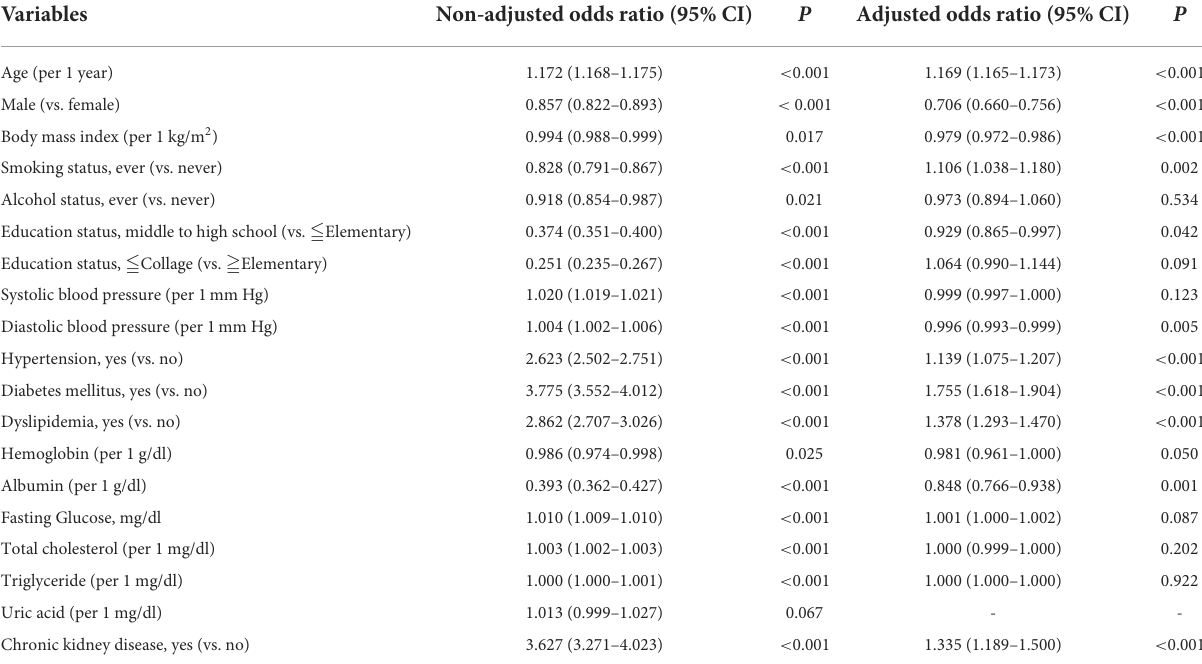
TABLE 2 Odds ratios for self-reported diagnosed cataracts in univariable and multivariable binary logistic analysis in the cross-sectional cohort ( n = 121,380).